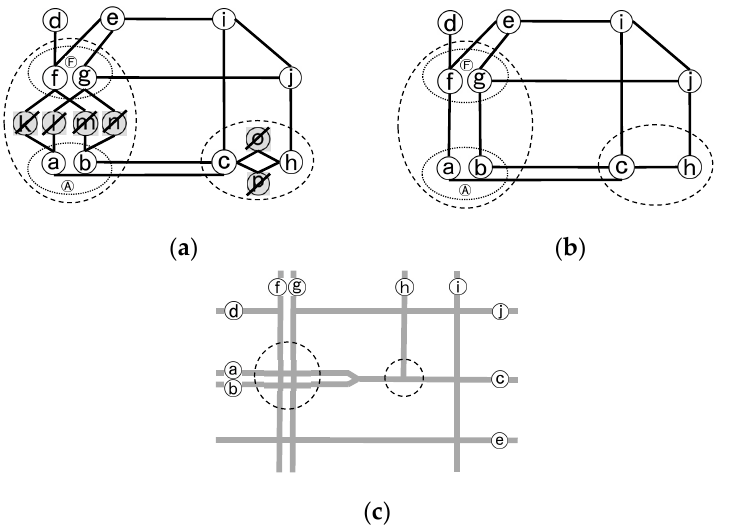
Figure 3. ( a – c ) The process of generalization of complex junction by discarding the interior secondary